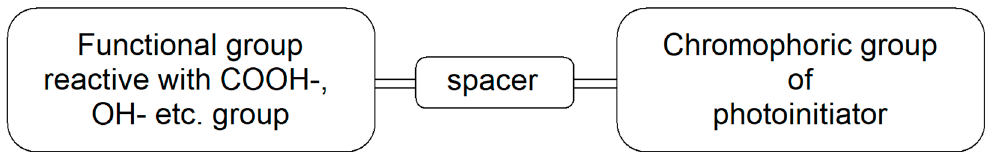
Figure 1. General scheme of saturated photoinitiators suitable for addition.